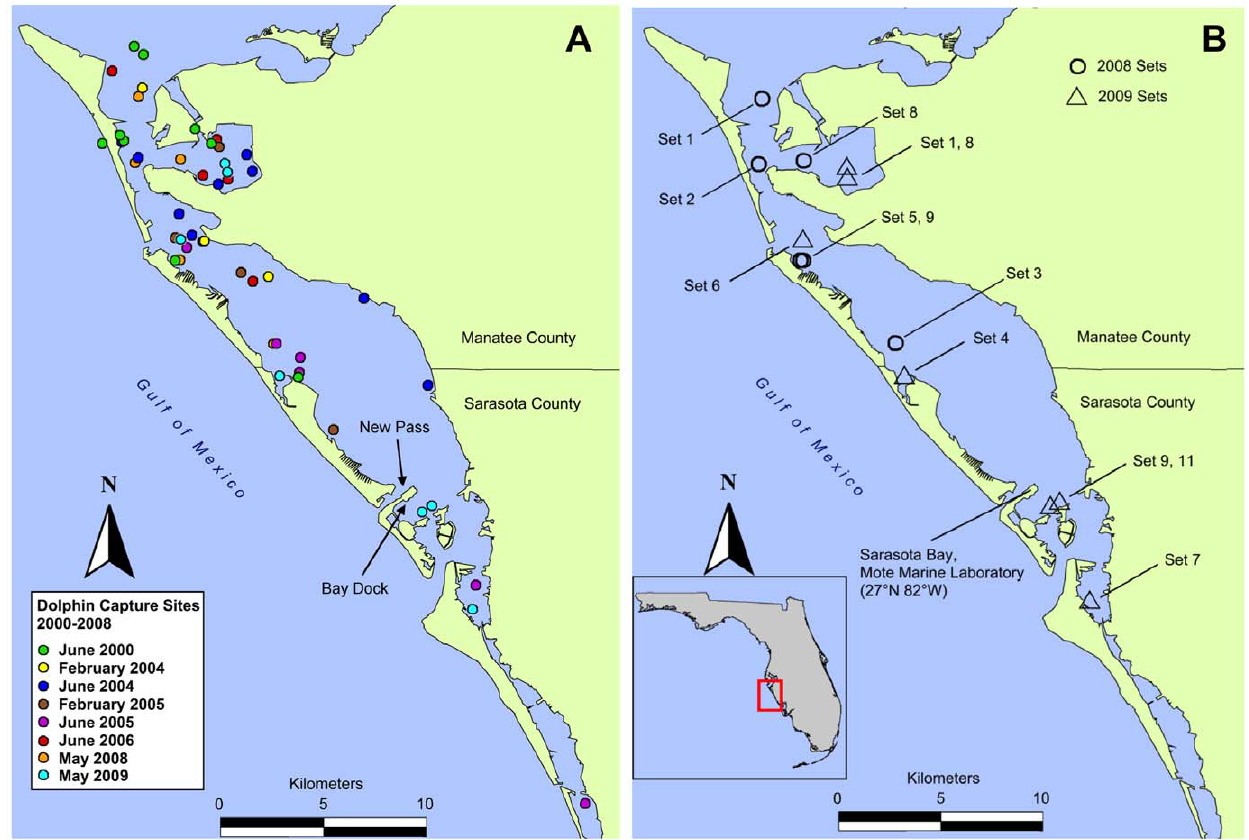
Figure 1. Locations of live captured bottlenose dolphins ( Tursiopstruncatus ) in Sarasota Bay, Florida, USA. Shown are (A) the captured locations for all sampled animals between 2000 and 2009 and (B) the specific 2008 and 2009 set sites where additional water sampling was also performed.